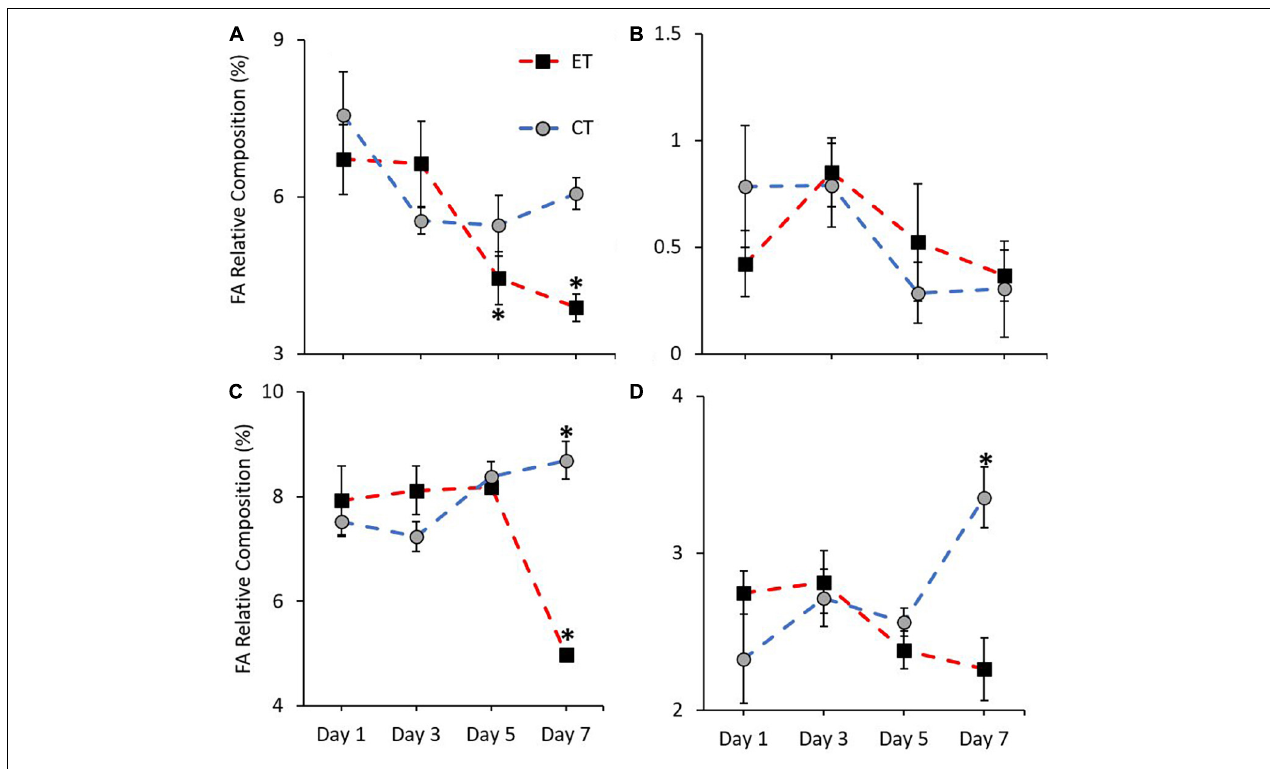
FIGURE 7 | Composition of most affected PUFA markers ( A = 18:3n6, B = 18:4n3, C = 20:5n3, and D = 22:6n3) in coral samples from CT and ET during experimental period. All data points are mean ± SE ( n = 9). Asterisk represents a significant difference ( p <